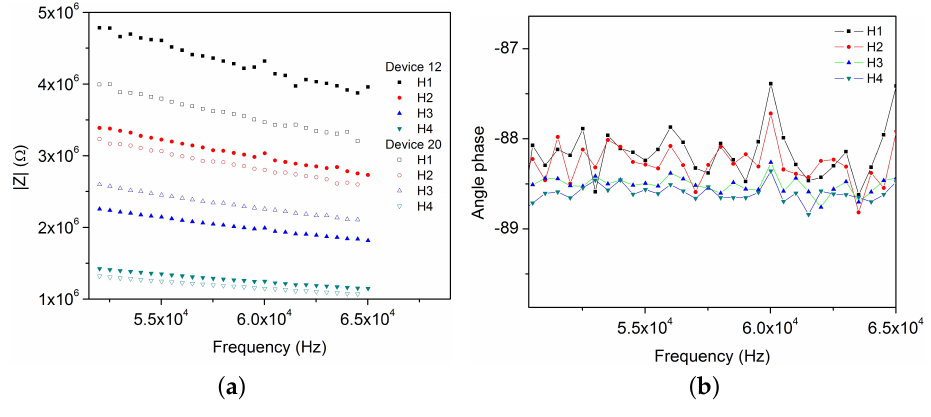
Figure 11. Bode diagrams of coplanar plates capacitors of dried CA (DCA) of devices 12 and 20. ( a ) impedance and ( b ) phase